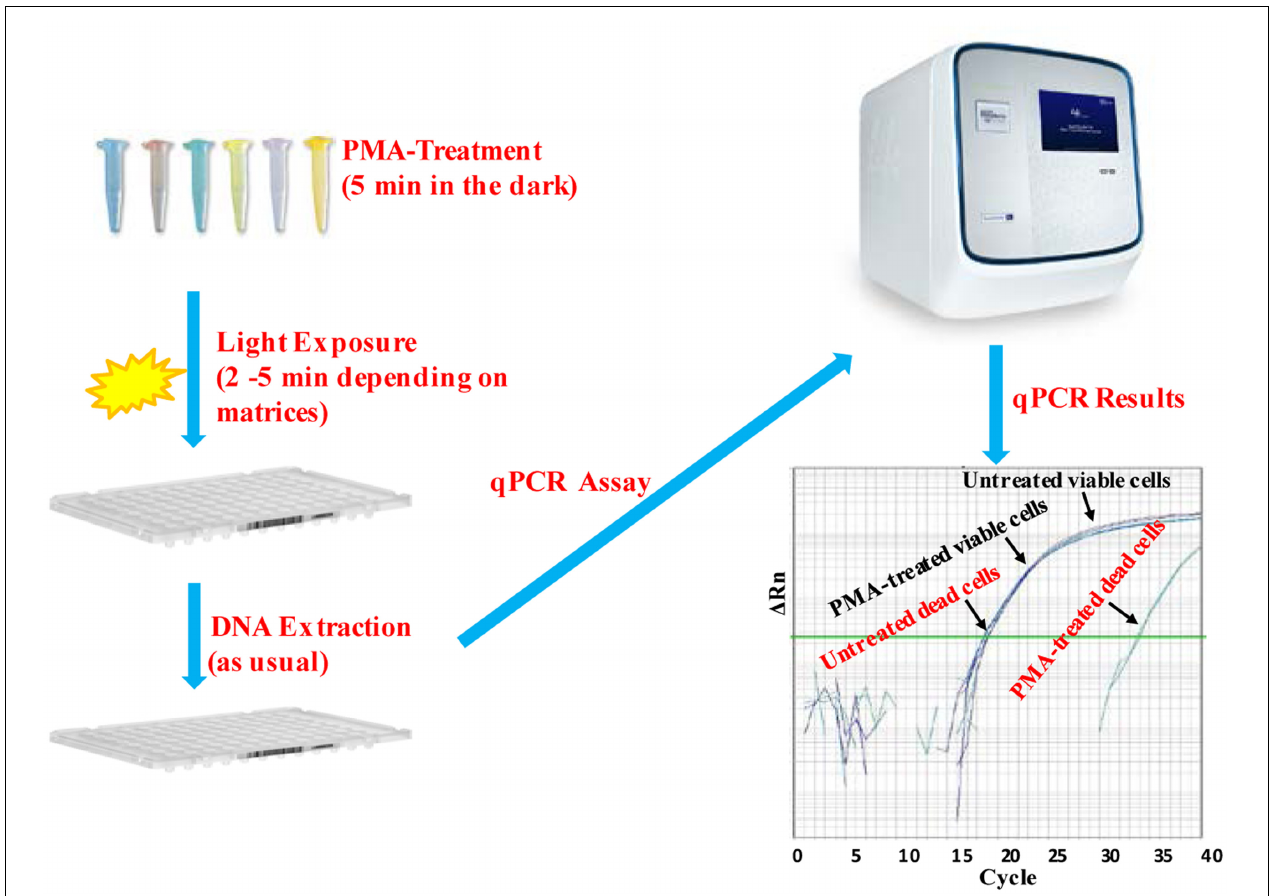
FIGURE 2 | Scheme of PMA treatment and PMA-qPCR